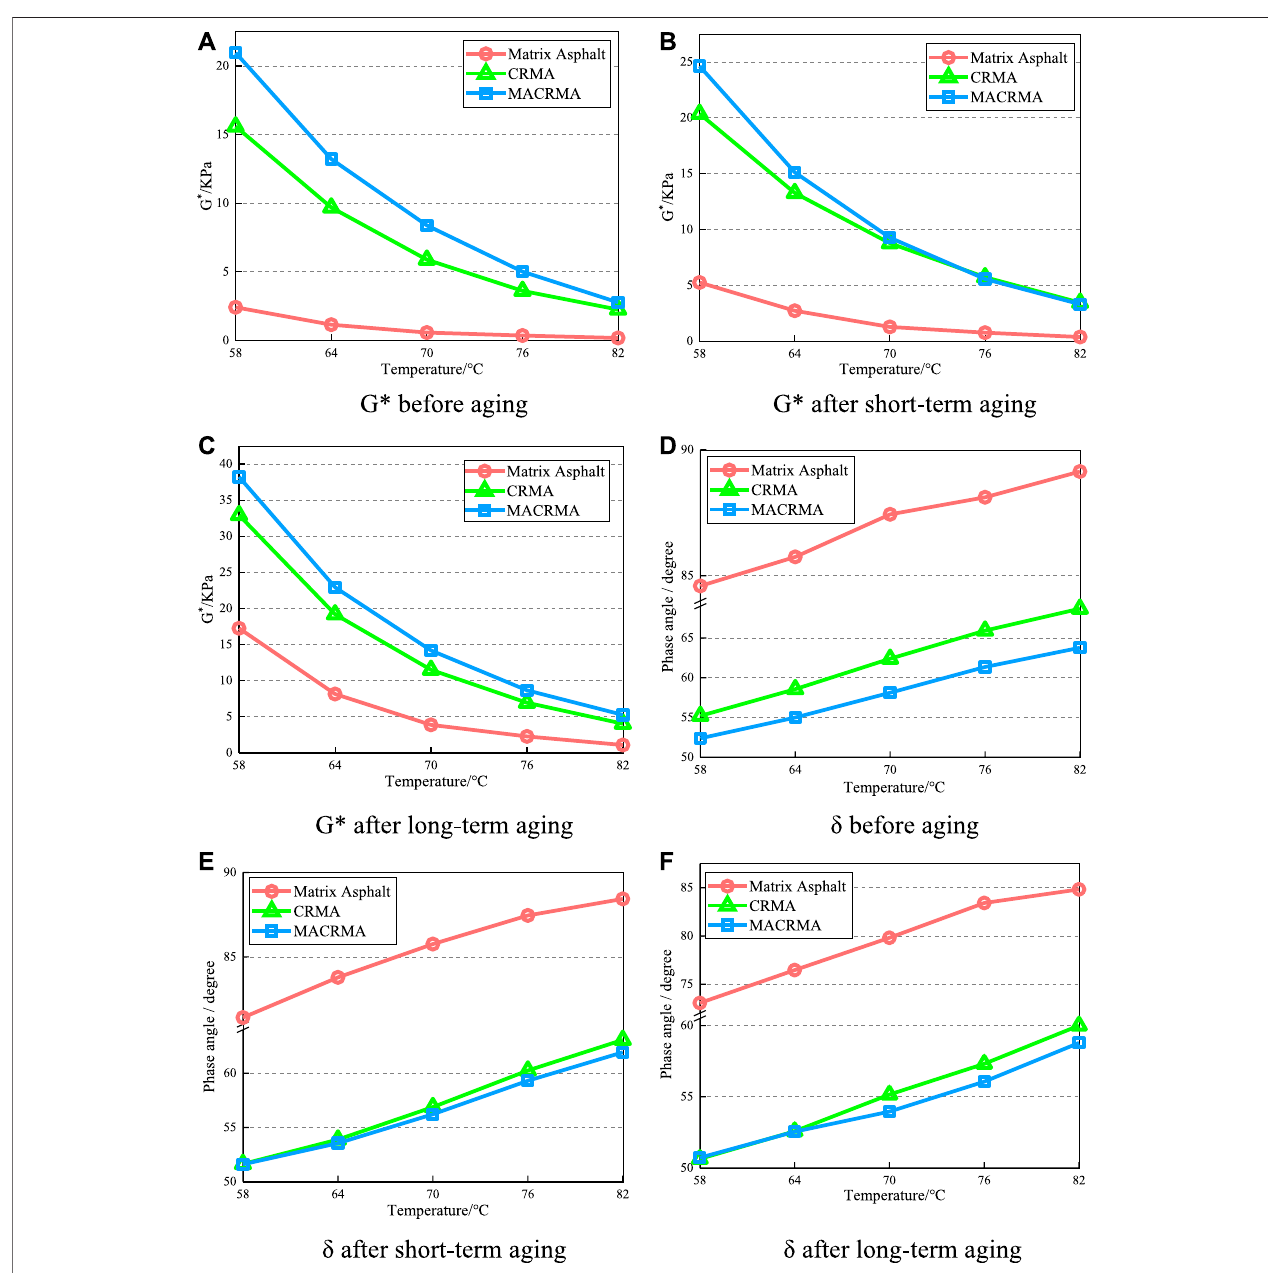
FIGURE 5 | The test results of G* and δ . (A) G* before aging, (B) G* after short-term aging, (C) G* after long-term aging, (D) δ before aging, (E) δ after short-term aging (F) δ after long-term aging.